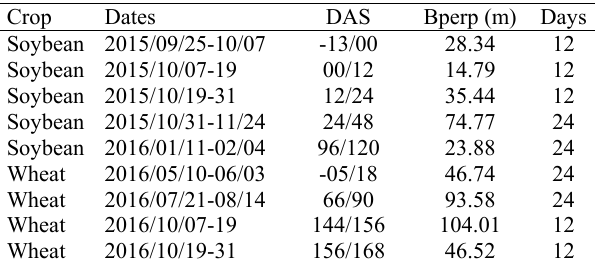
Table 3. SAR interferometric dates.